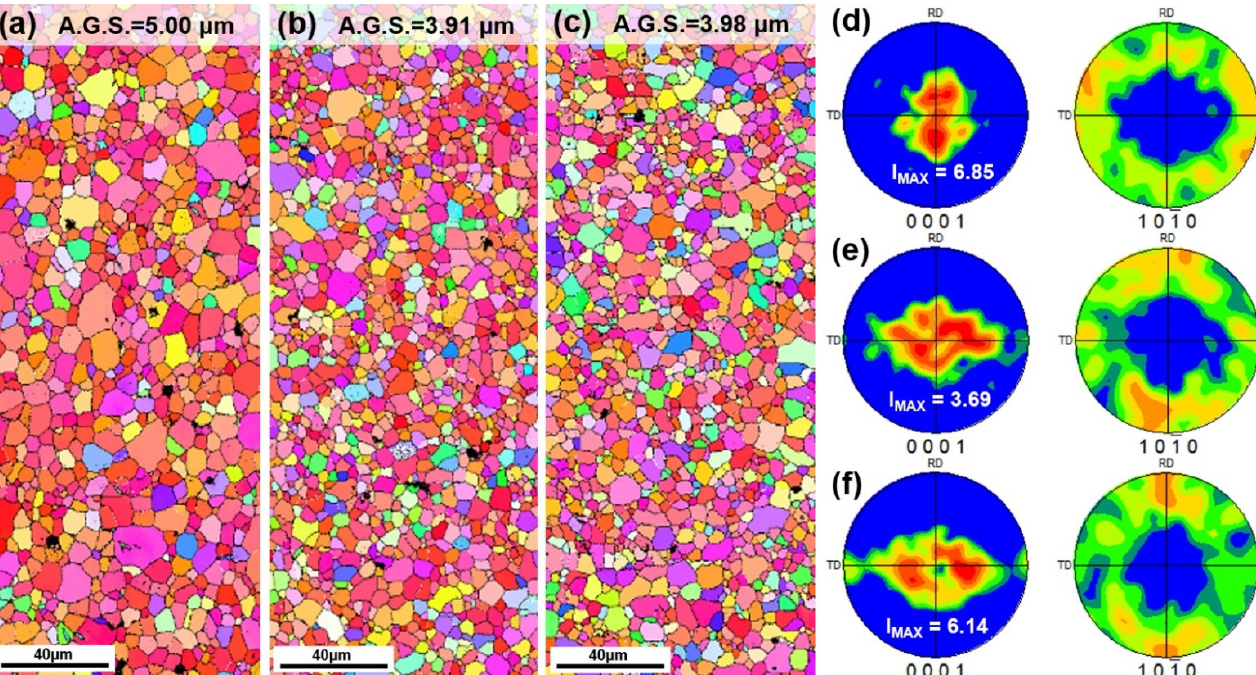
Figure 4. EBSD-IPF maps and pole figures for basal (0002) and prismatic (10-10) planes of the annealed sheets: ( a , d ) AZXW3100, ( b , e ) AZXW2100, and ( c , f ) AZXW1100.